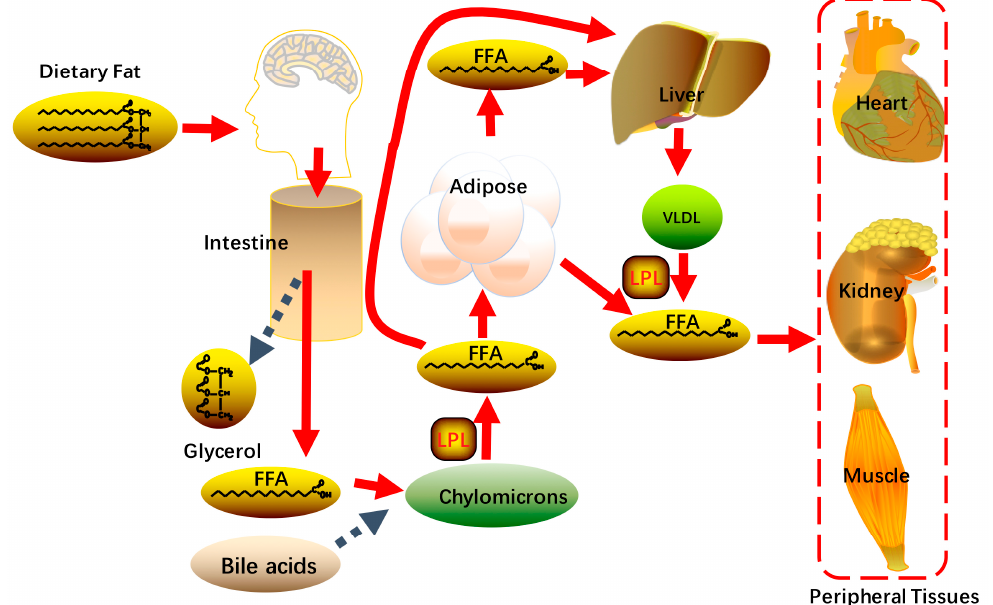
Figure 2. Digestion and metabolism of dietary lipids: Dietary fat is hydrolyzed to glycerol and free fatty acids (FFA) in intestine. Most of the FFA are delivered to adipose tissue for storage; some are transported to the liver for lipid synthesis. Excessive free fatty acids in the peripheral circulation lead to lipid ectopic deposition in tissues.